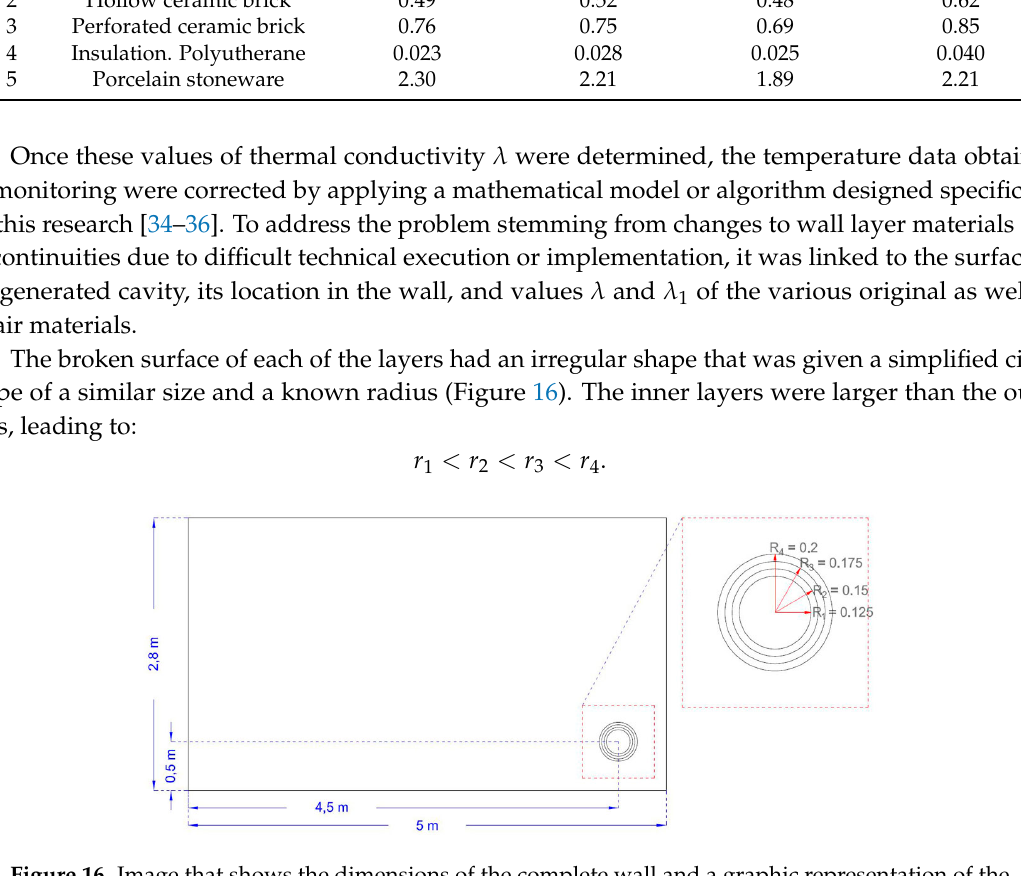
Table 7. Results of U-value across different scenarios.